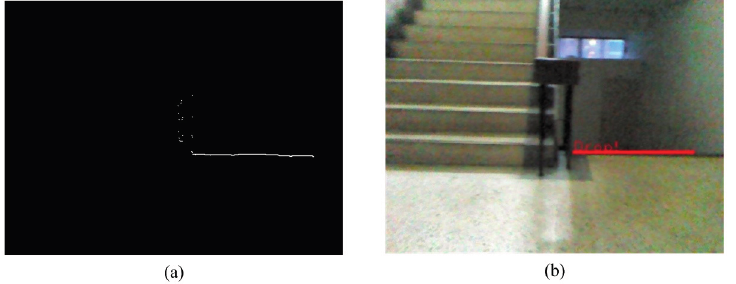
Figure 13. The results for the detection of descending stairs. ( a ) Suspicious points of downstairs depth map; ( b ) The results of the Hough